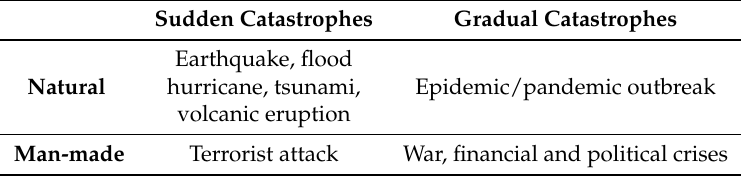
Table 1. Examples of sudden, gradual, natural and man-made catastrophes. Sudden Catastrophes Gradual Catastrophes Earthquake, flood Natural hurricane,